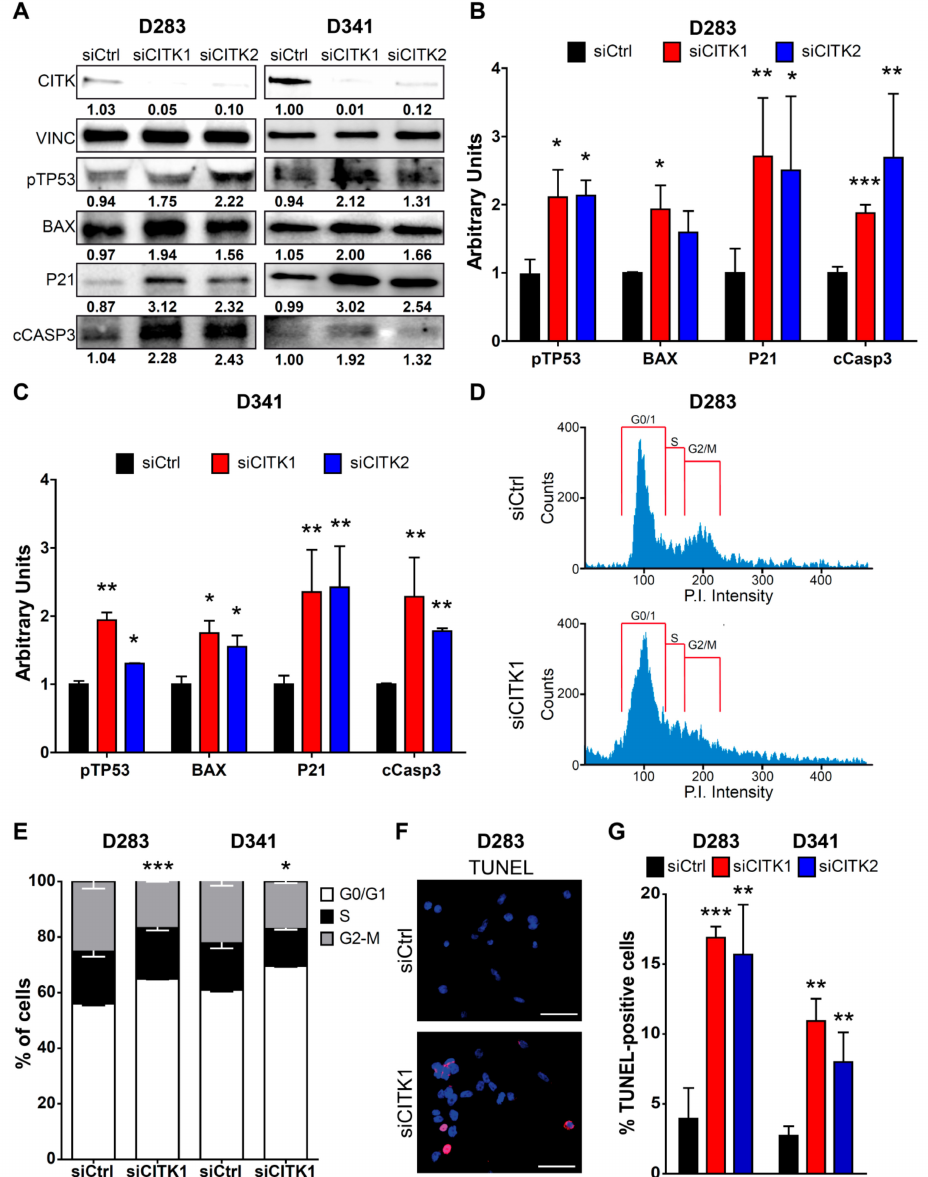
Figure 2. CITK knockdown leads to apoptosis and cell-cycle arrest in D283 and D341 cell lines. ( A ) Western blot analysis of total lysates from D283 and D341 cells, 100 and 72 h, respectively, after treatment with nontargeting (siCtrl) or CITK-specific siRNAs (siCITK1 and siCITK2). The level of CITK, pTP53, BAX, P21 and cCASP3 were analyzed, and the internal loading control was vinculin (VINC). ( B , C ) Quantification of the relative density of pTP53, BAX, P21 and cCASP3 in D283 and D341-treated cells, normalized to VINC and siCtrl average values. ( D ) Example of cell-cycle profile of D283 cells transfected with siCtrl and siCITK1 for 100 h. G0 / G1, S and G2-M phases are shown. ( E ) Quantification of the percentage of D283 and D341 treated cells in the di ff erent cell-cycle phases. ( F ) Representative image of D283 processed for immunofluorescence 100 h after transfection with nontargeting or CITK-specific siRNA and stained with DAPI and TUNEL assay. ( G ) Quantification of the percentage of TUNEL positive nuclei in D283 and D341 treated cells. All quantifications were based on three independent biological replicates. Error bars, SEM. *, p < 0.05; **, p < 0.01, ***, p < 0.001; two-tailed Student’s t -test. Scale bars, 10 µ